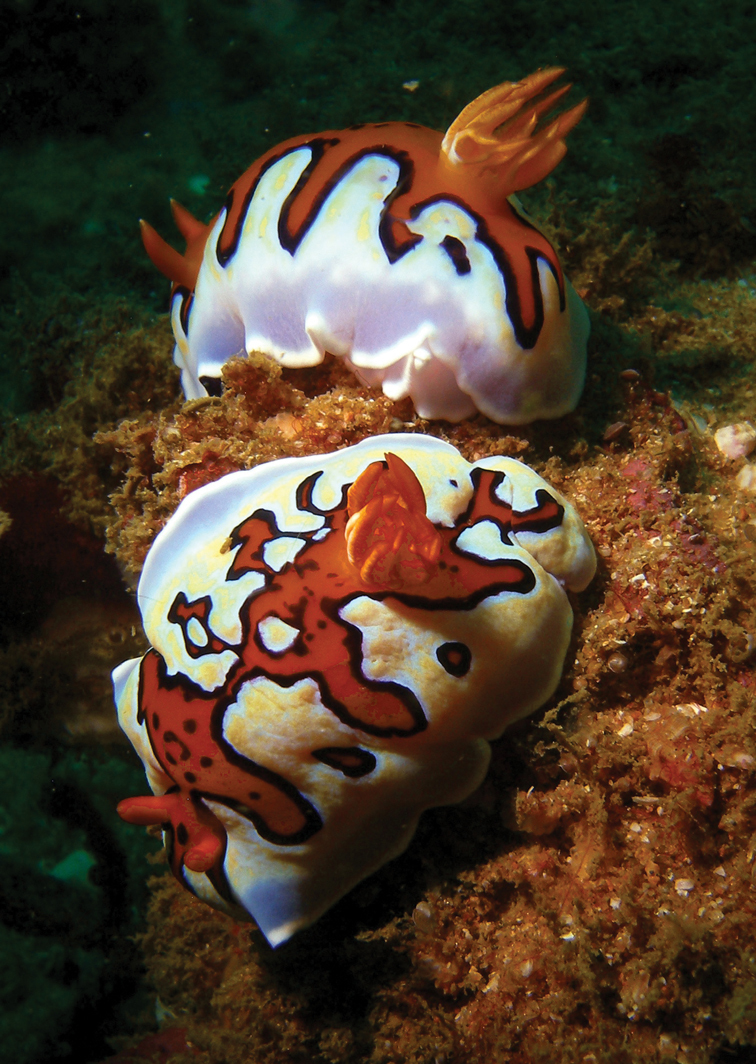
Chromodoris gleniei, Sri Lanka, photo: S Kahlbrock (no spcm).